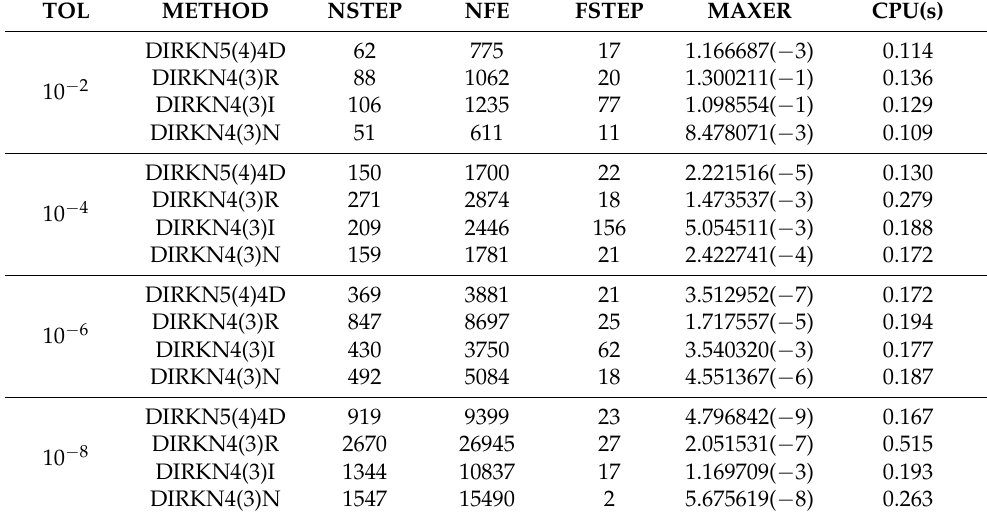
Table 2. Data for Example 1.